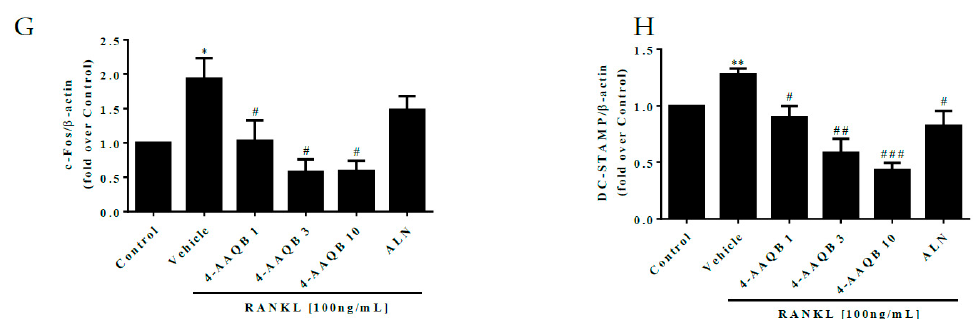
Figure 4. Effects of 4-AAQB on the osteoclastogenesis signaling pathway. Osteoclastogenesis proteins were assayed by western blotting after exposure to v-Xg ( A ) conditions for 24 h. The cells were treated with 4-AAQB (1, 3, or 10 μ M) or ALN (10 μ M) combined with RANKL for 54 h. The quantitative results of NFATc1 ( B ), c-Fos ( C ), and DC-STAMP (D) represent the mean ± SEM (n = 3). In addition, after exposure to μ Xg ( E ) conditions for 24 h, the cells were treated under the same stimulation conditions as the v-Xg group for 48 h. The quantitative results ( F – H ) represent the mean ± SEM (n = 3). * p < 0.05, ** p < 0.01 and *** p < 0.001 versus control; # p < 0.05, ## p < 0.01, and ### p < 0.001 versus RANKL.